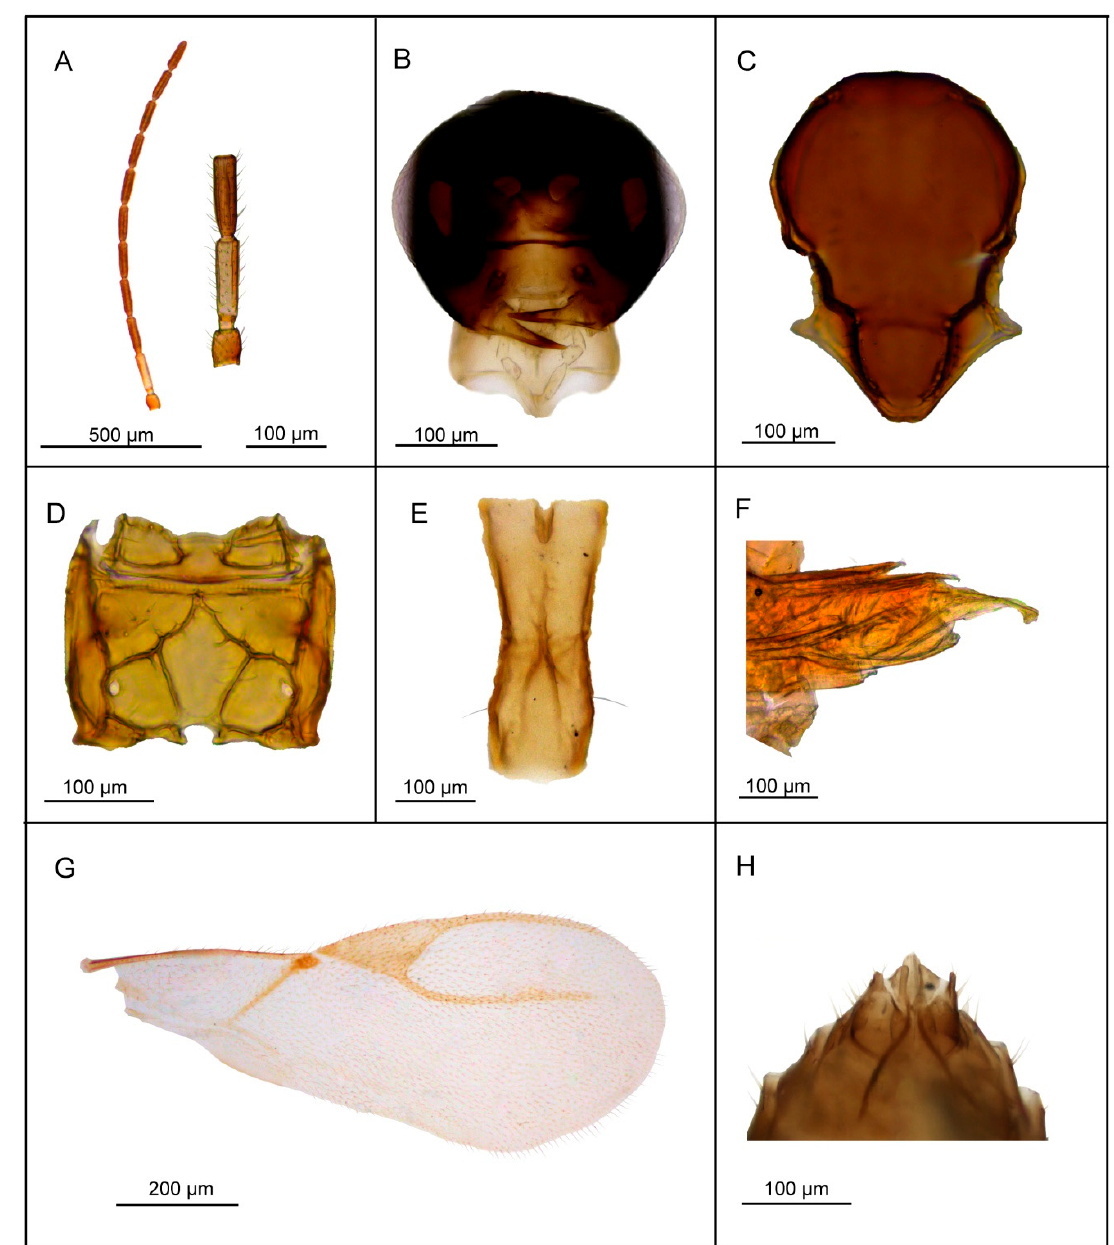
Figure 9. Lipolexis peregrinus sp. n.: female ( A ) antenna and F1 and F2; ( B )head; ( C ) mesoscutum; ( D ) propodeum; ( E ) petiole, dorsal view; ( F ) ovipositor sheath; ( G ) forewing; male ( H ) aedeagus. Female